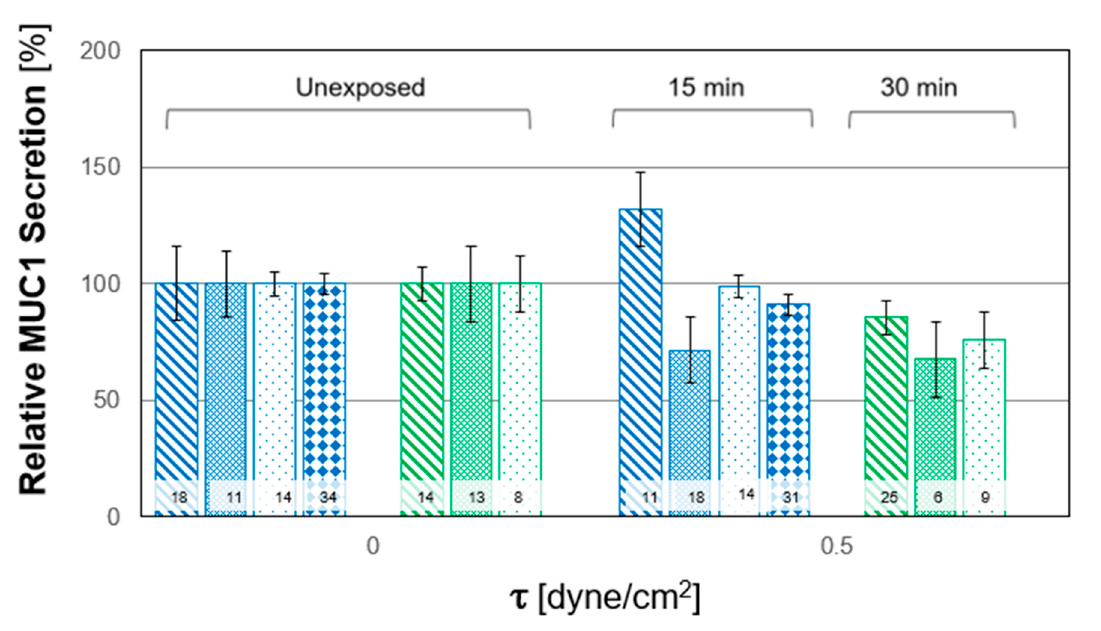
Figure 7. Relative MUC1 secretion measurements in human conjunctival epithelial cell (HCEC) in vitro model in single tests with HCEC cultured from different subjects. The cultures were exposed to wall shear stresses (WSS) of 0.5 dyne/cm 2 for durations of 15 min (4 repetitions) and 30 min (3 repetitions). Columns with the same pattern and color represent the control and those after exposure to WSS in a single test. The data obtained after exposure to WSS were scaled by the averaged data for the unexposed control. The values inside the bars denote the number of data points calculated from the sub-regions (n).